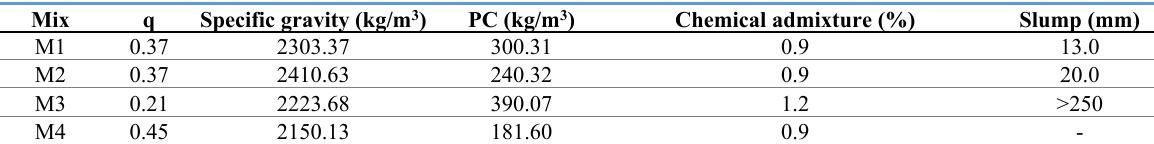
Table 7. Results in fresh